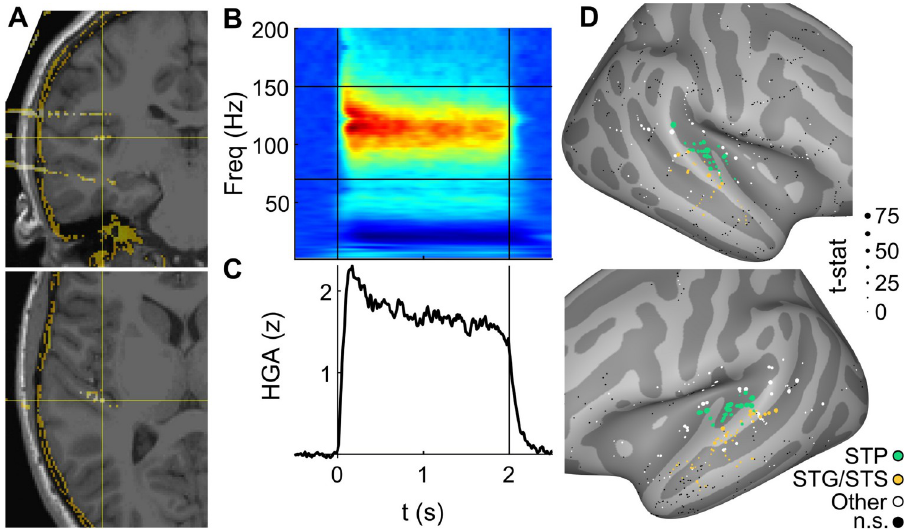
Fig 1. Auditory-evoked HGA. (A) Example channel in left HG, patient P7, shown in coronal (upper panel) and axial (lower) slices. (B) Auditory-evoked spectral response averaged across all NatS stimuli in channel from (A). Vertical lines represent stimulus on- and offset, with horizontal lines demarcating frequency boundaries for broadband HGA at 70 and 150 Hz. (C) Mean HGA in the same channel. (D) Auditory responsiveness, quantified as the 2-sample t-value between mean HGA in 500 ms pre- and poststimulus onset windows. Small black dots represent channels with no auditory response, i.e., t-values that failed to reach significance ( p < 0.05, FDR corrected). Associated data are located on Zenodo in the Fig 1B and 1C folder (doi: 10.5281/zenodo.6544488). F AU : AbbreviationlistshavebeencompiledforthoseusedthroughoutFigs 1 (cid:0) 4 : Pleaseverifythatallentriesarecorrect : DR, false discovery rate; HG, Heschl’s gyrus; HGA, high-gamma activity; NatS, Natural Sounds; STG, superior temporal gyrus; STP, supratemporal plane; STS, superior temporal